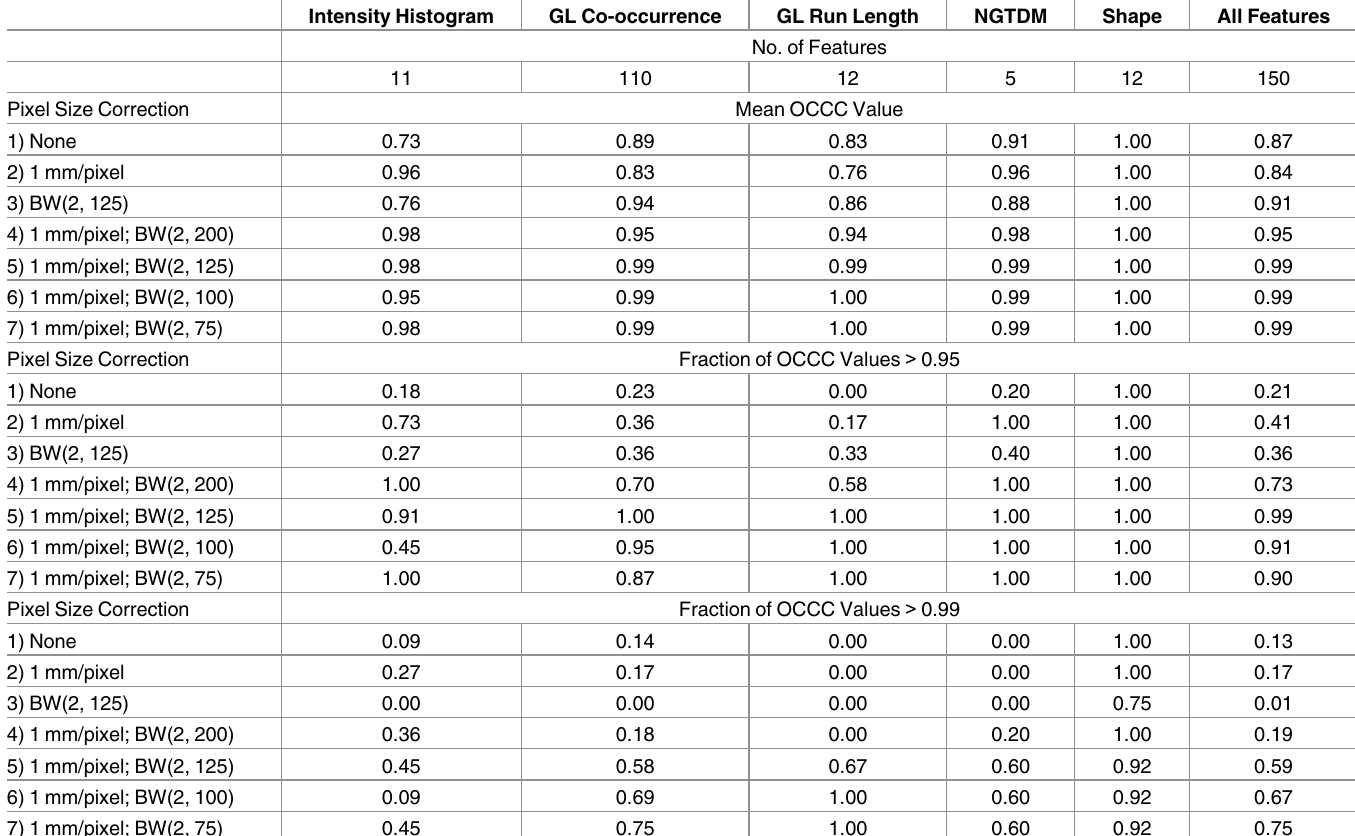
Table 2. Summaryof the OCCC values for 150 radiomics features. Intensity Histogram GL Co-occurrence GL Run Length NGTDM Shape All Features